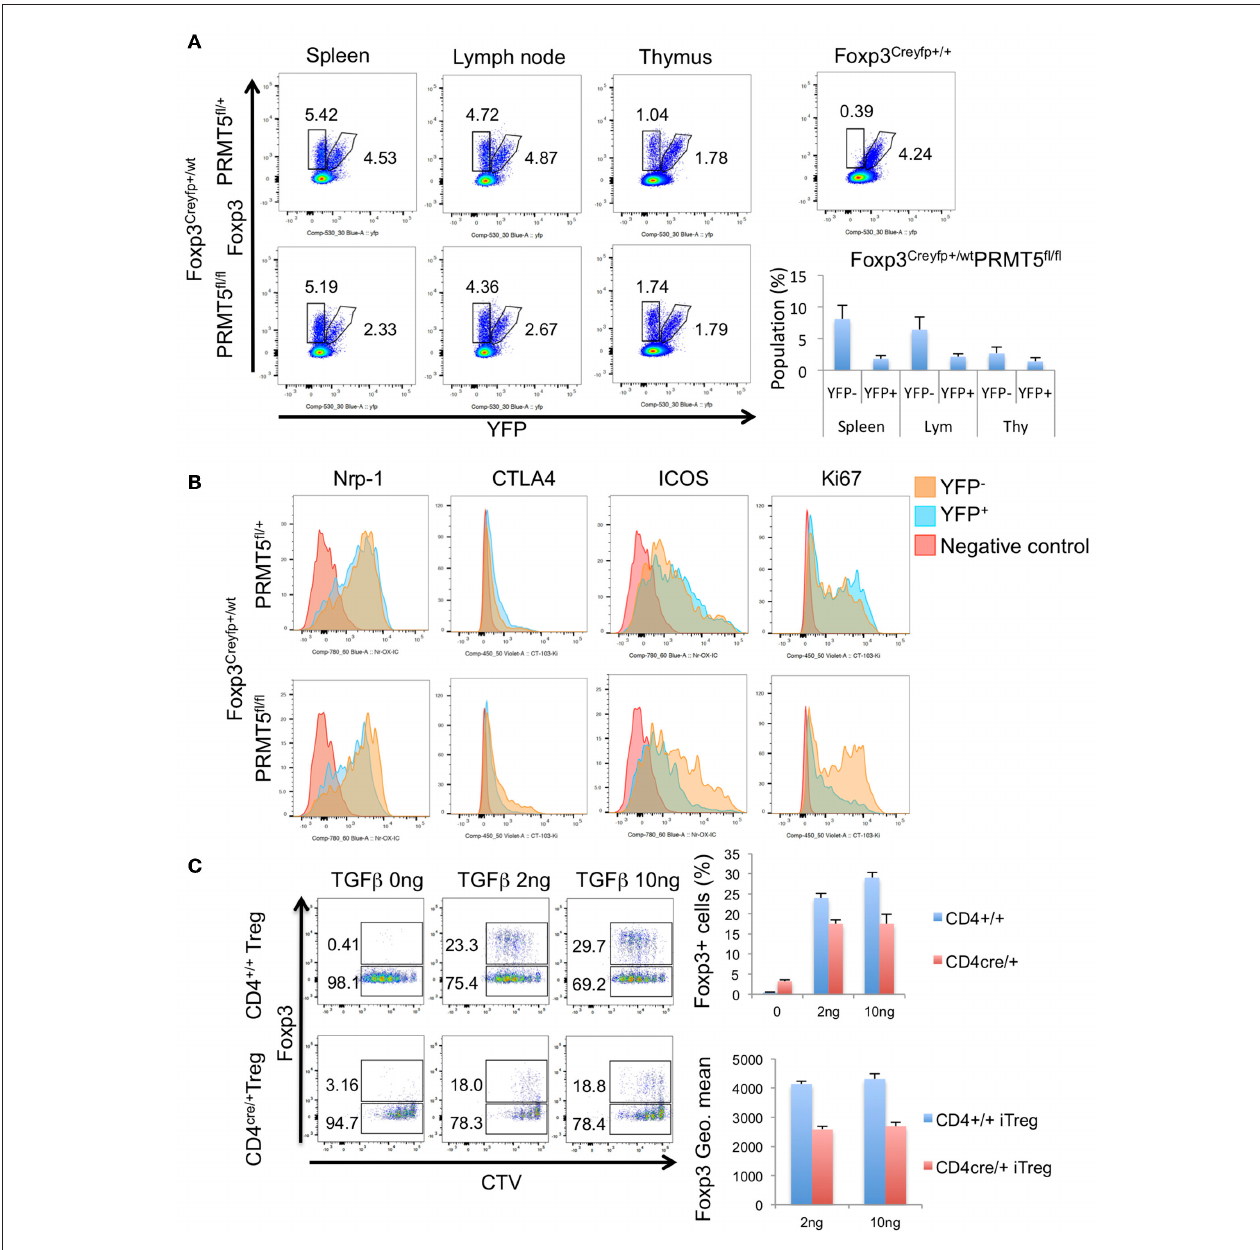
FIGURE 3 | Populations and phenotypes of Tregs in Foxp3 Creyfp + / − -PRMT5 fl / + or -PRMT5 fl / fl mice. (A) cells were harvested from spleen, lymph node, and thymus. Populations of YFP + or YFP − cells were analyzed. Numbers show the percentage of gated cells in CD4 + TCR β + cells. (B) phenotypes of Tregs. Each type of YFP + or YFP − cell was gated as (A) . Then expression levels of indicated proteins were analyzed. Data shows a representative of 3 different mice. (C) iTreg induction of CD4 + T cells from CD4 cre -PRMT5 fl / fl mice. CTV-labeled CD45RB high CD25 low naïve CD4 + T cells were treated with indicated concentrations of TGF β , 20 IU/ml